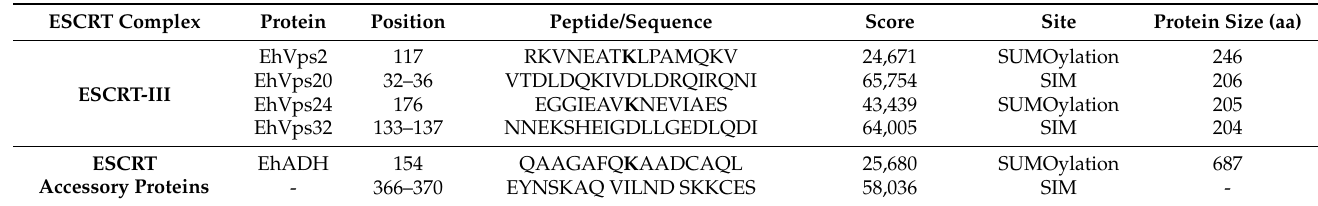
Table 3. Predicted SUMOylation sites of ESCRT-III and EhADH